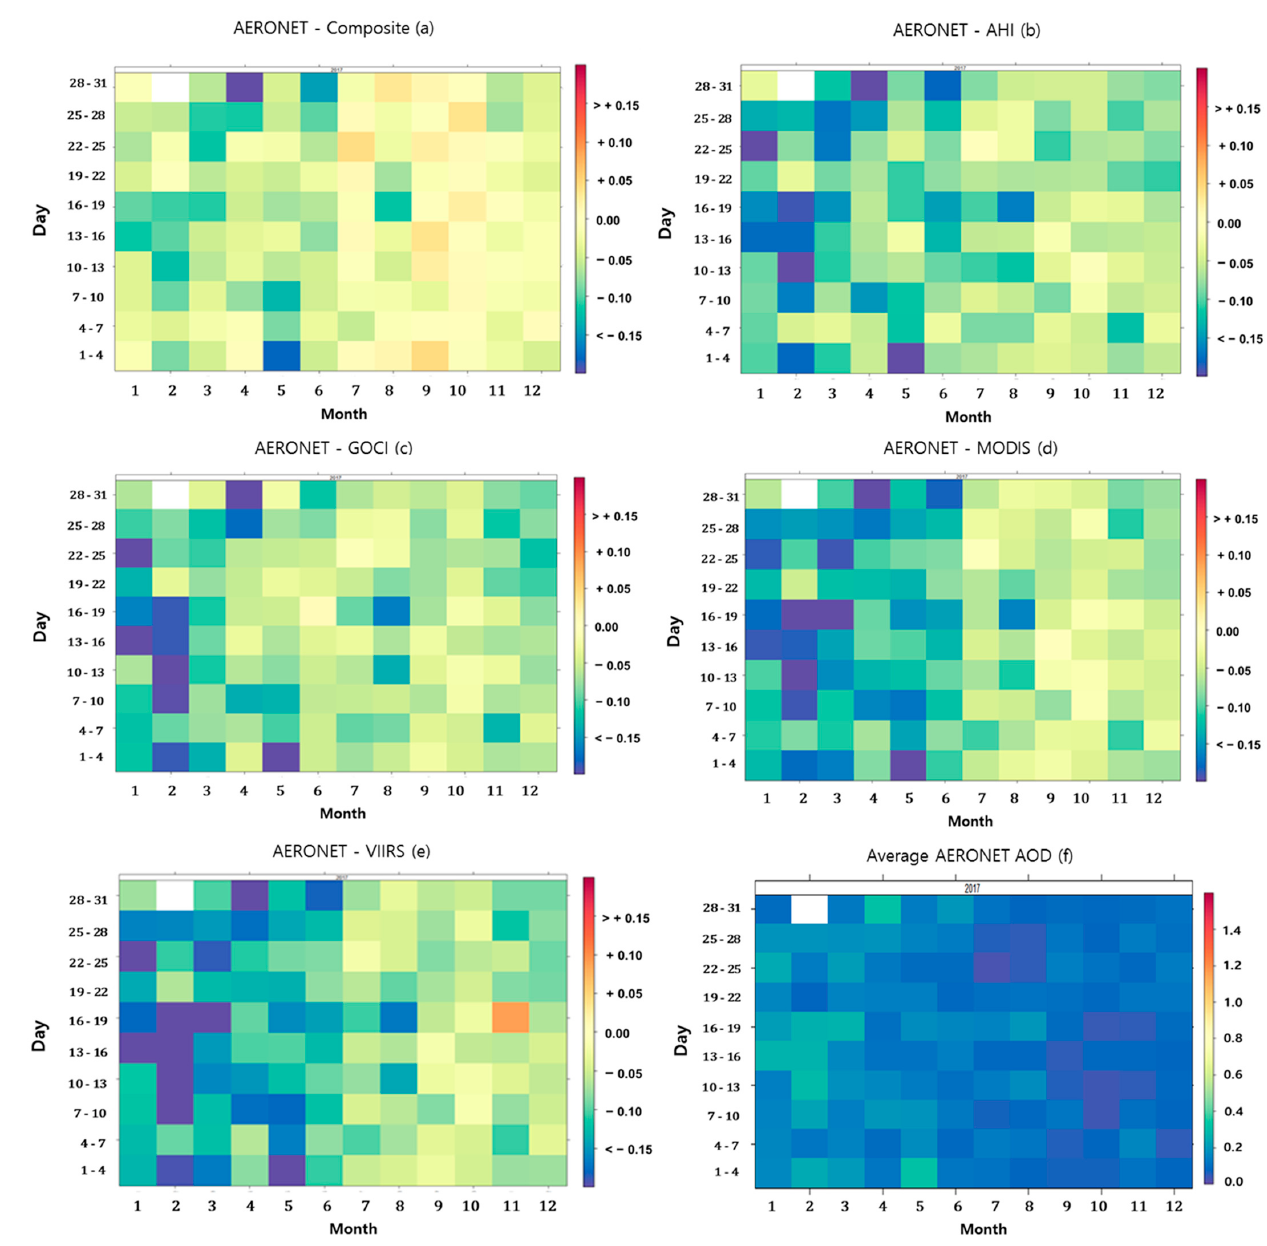
Figure 10. Seasonal and diurnal mean deviation of AOD between AEORNET, composite, and satellite data during 2017: ( a ) Composite, ( b ) Himawari-8/AHI, ( c ) COMS/GOCI, ( d ) Aqua Terra/MODIS, and ( e ) Suomi-NPP/VIIRS ( f ) AERONET Average AOD.